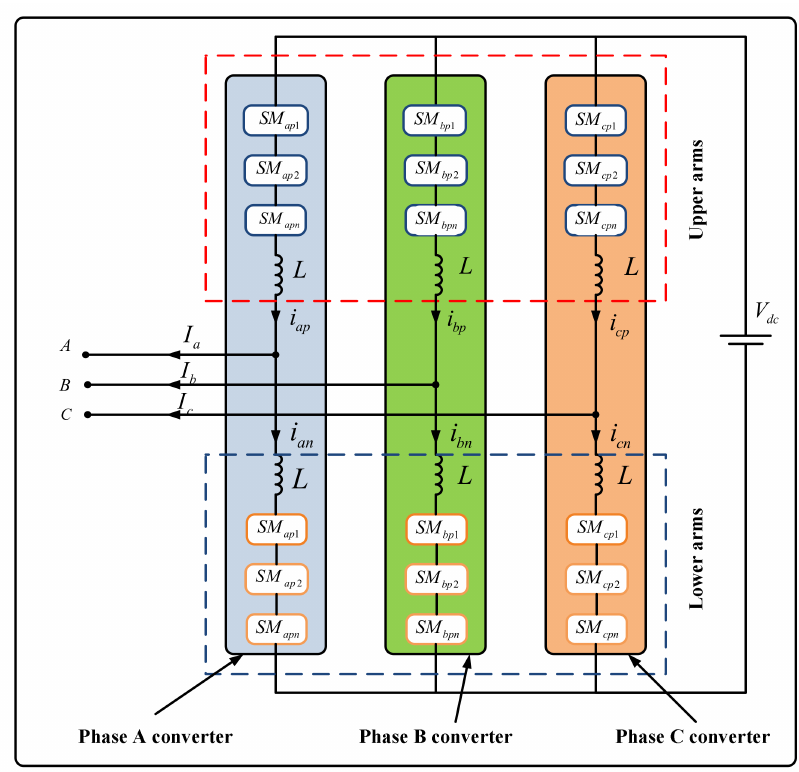
Figure 1. Structure of a three-phase MMC with half-bridge submodules [33].